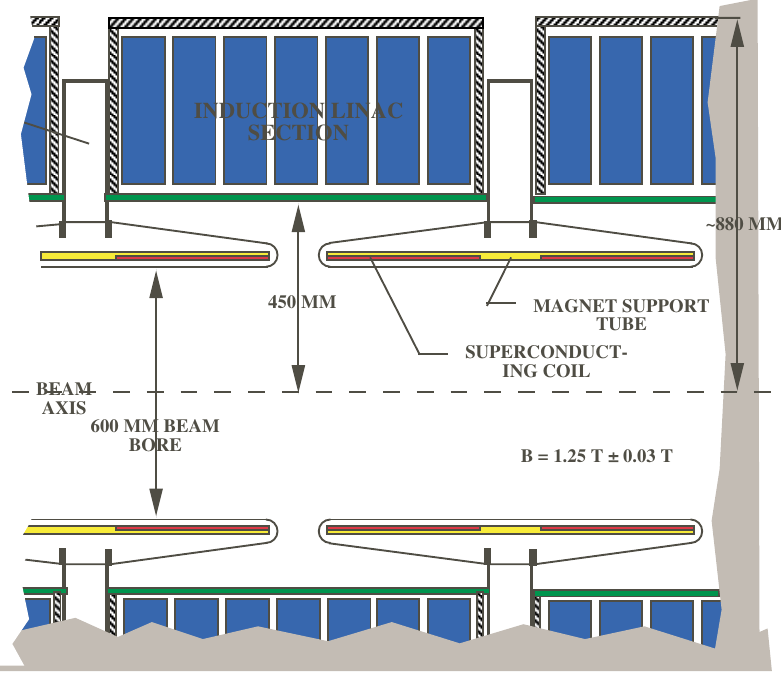
FIG. 15. (Color) Cross section of the induction cell and transport